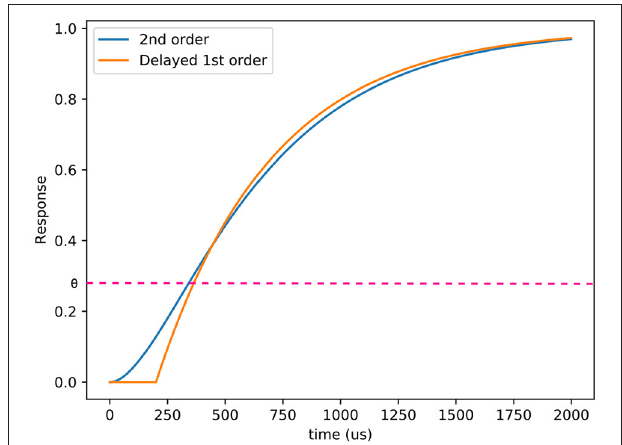
FIGURE 2 | Comparison between the responses of a delayed first order low pass filter and a second order low pass filter. θ represents one of the thresholds of the comparators. In this case, τ c